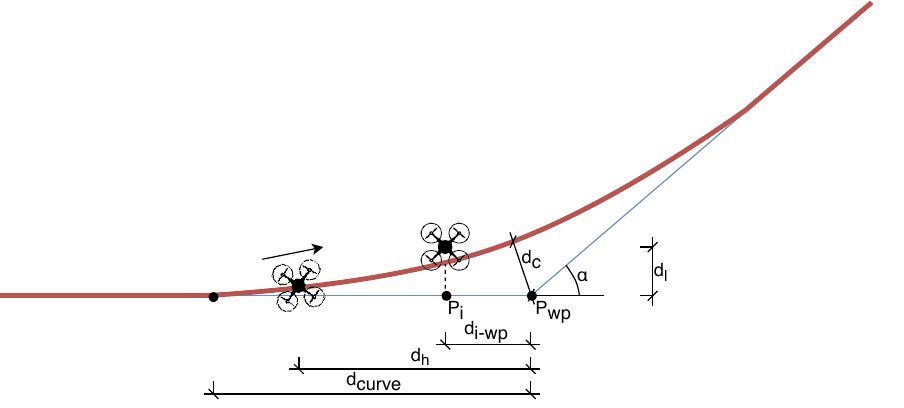
Figure 10. Safe location on curve